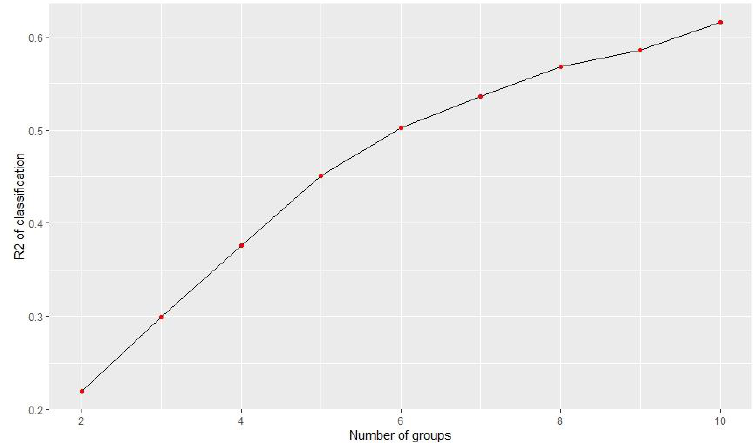
Figure 1. Impact of the number of groups on the explained variance.